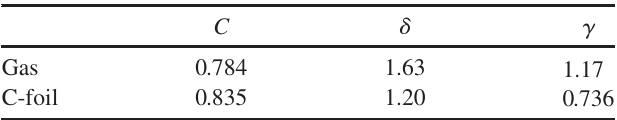
TABLE V. Values of the fitting parameters C , (cid:4) , and (cid:5) for the in this study. fitting function q eq